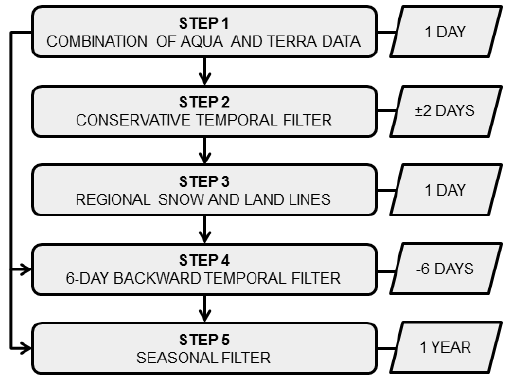
Figure 1. Flowchart of the cloud removal procedure representing the step order and the temporal window considered in each